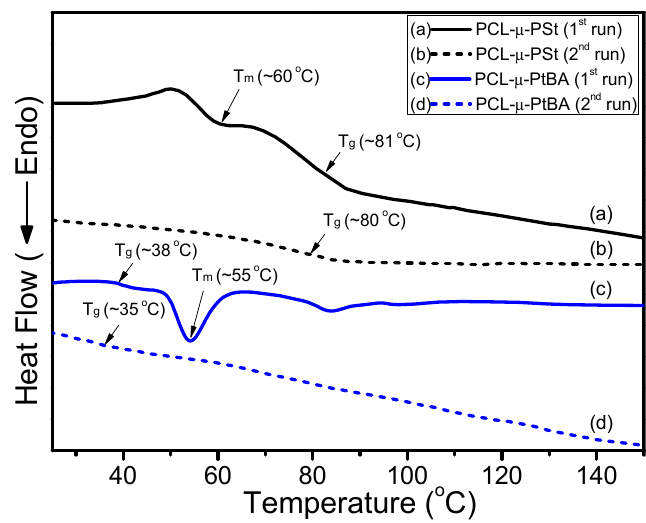
Figure 7. DSC traces of ( a , b ) PCL- μ -PSt and ( c , d ) PCL- μ -PtBA star copolymers ( a , c : first run and b , d : second run).